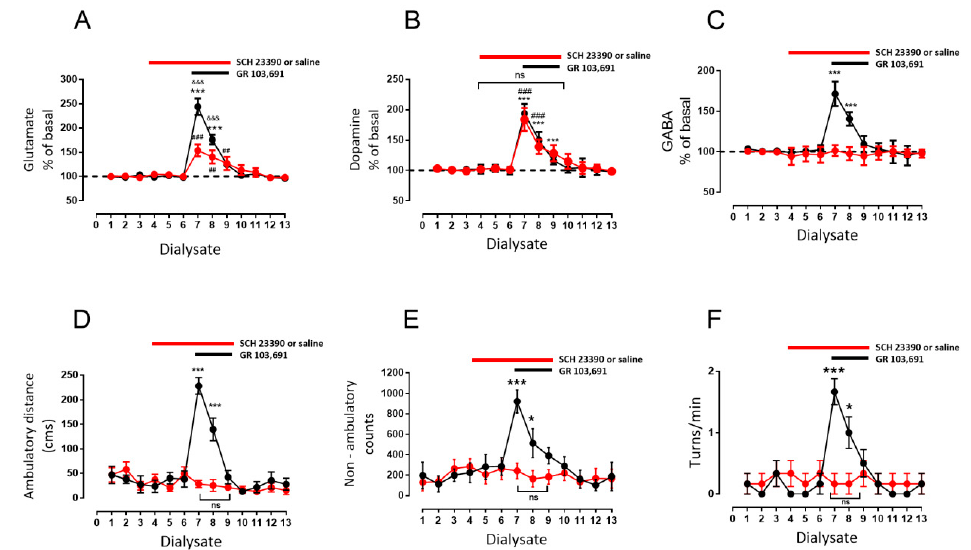
Figure 3. Blockade of intra-nigral D1R prevents the behavioral e ff ect of intra-nigral D3R antagonist and decreases the increments of glutamate and GABA. ( A – C ) demonstrate the e ff ect of intra-nigral D1R blockade with SCH 23,390 (1 µ M, from dialysate three to eight) on the interstitial concentration of glutamate, dopamine, and GABA, alone or in co-perfusion, of D3R antagonist GR 103,691 (100 nM, from dialysate six to eight). Black circles indicate a group of animals perfused with saline instead of SCH 23,390 as control for the red-circles group, perfused with the drug prior to the D3R blockade. ( D – F ) exhibit the behavioral e ff ects of co-superfusion of the antagonists in ambulatory distance, non-ambulatory counts, and in turns / min, respectively. * p < 0.05 and *** p < 0.001 with respect to dialysate six (black-circles group); ### p < 0.001 with respect to dialysate six (red-circles group); and &&& p < 0.001 (black-circles group with respect to red circles); ns, without significant di ff erences between dialysates. Two-way ANOVA followed by Tukey, n = 6 rats per group. With respect to animals in which D1Rs were blocked, it can be observed (Figure 3A–C) that SCH 23,390 itself did not modify glutamate nor dopamine nor GABA baseline levels, even after 60 perfusion min (Figure 3A, glutamate dialysate number three: 98 ± 1 vs. dialysate number six: 100 ± 2, mean difference 2, ns, F(12,60) = 29.43; Figure 3B, dopamine dialysate number three: 99% ± 1% vs. dialysate number six: 101% ± 2%, mean difference − 2, ns, F(12,60) = 50; Figure 3C, GABA dialysate number three: 99 ± 1 vs. dialysate number six: 96 ± 4, mean difference 3, ns, F(12,60) = 11.69; two-way